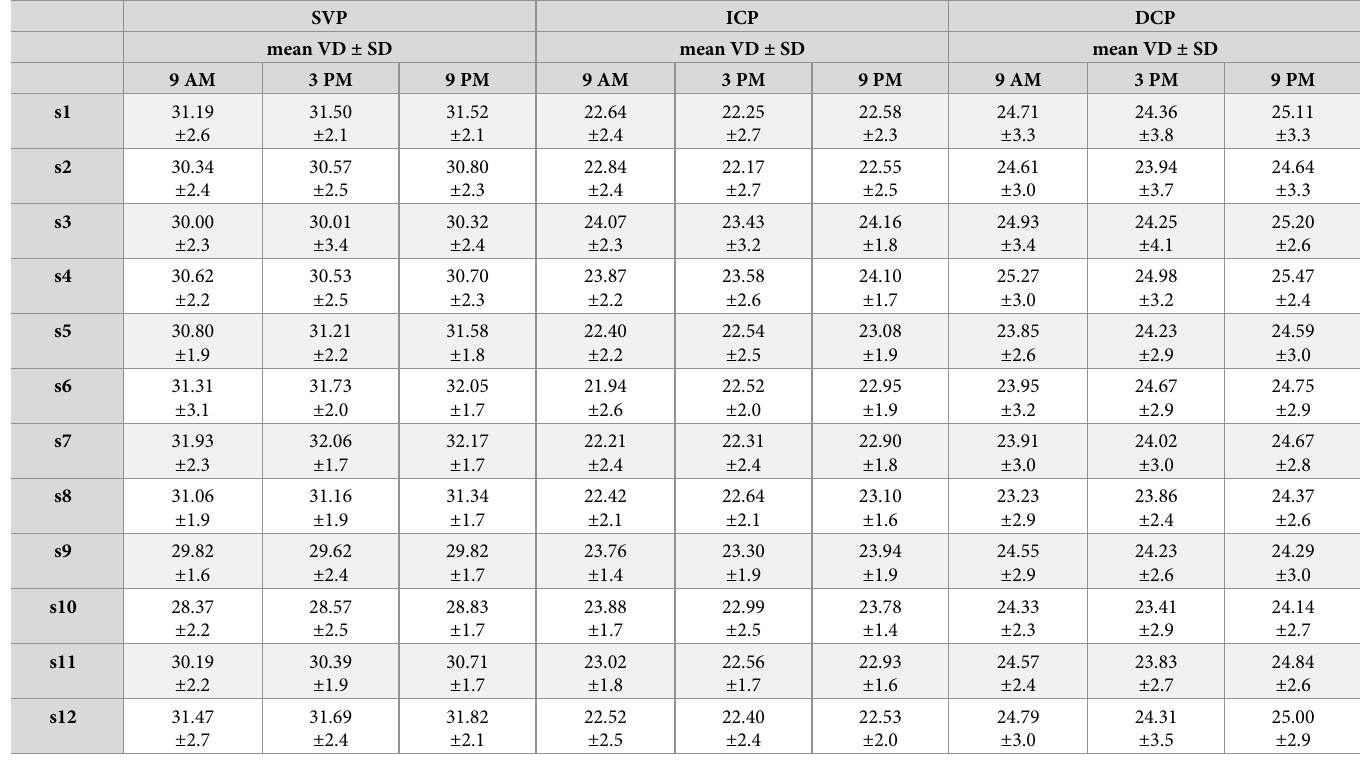
Table 3. Sectorial mean vessel density with standard deviation for each retinal sublayer at the corresponding time of measurement.